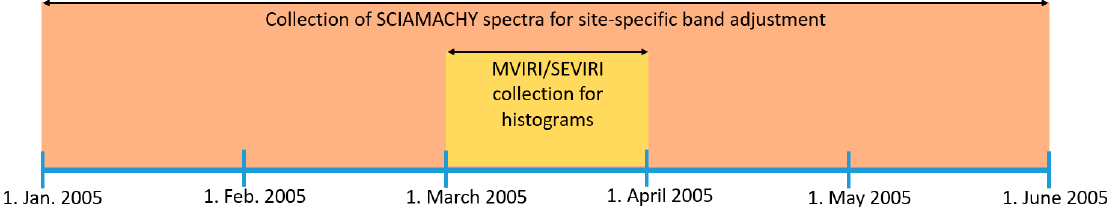
Figure 6. Illustration of the approach for the MVIRI/SEVIRI comparison. Site-specific spectral band adjustment functions between the two MVIRI datasets and the SEVIRI HRVIS band are computed based on SCIAMACHY spectra that are collected during a five-month period. The five-month period envelops the one-month period during which the actual MVIRI and SEVIRI data are collected that are displayed in the histograms.